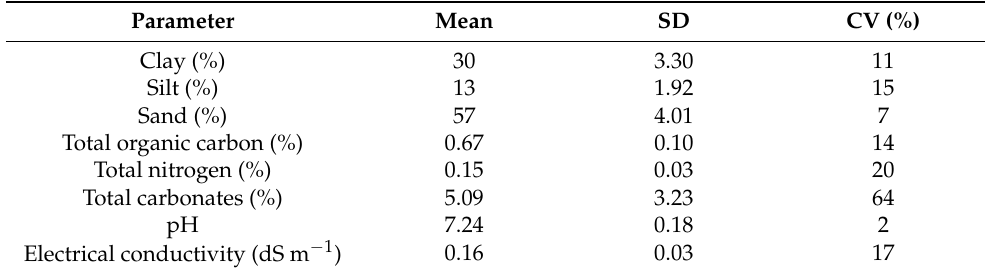
Table 1. Characteristics of the soil of the studied area. Parameter Mean SD CV (%) Clay (%) 30 3.30 11 Silt (%) 13 1.92 Sand (%) 57 4.01 Total organic carbon (%) 0.67 0.10 Total nitrogen (%) 0.15 0.03 Total carbonates (%) 5.09 pH 7.24 0.18 Electrical conductivity (dS m − 1 ) 0.16 0.03